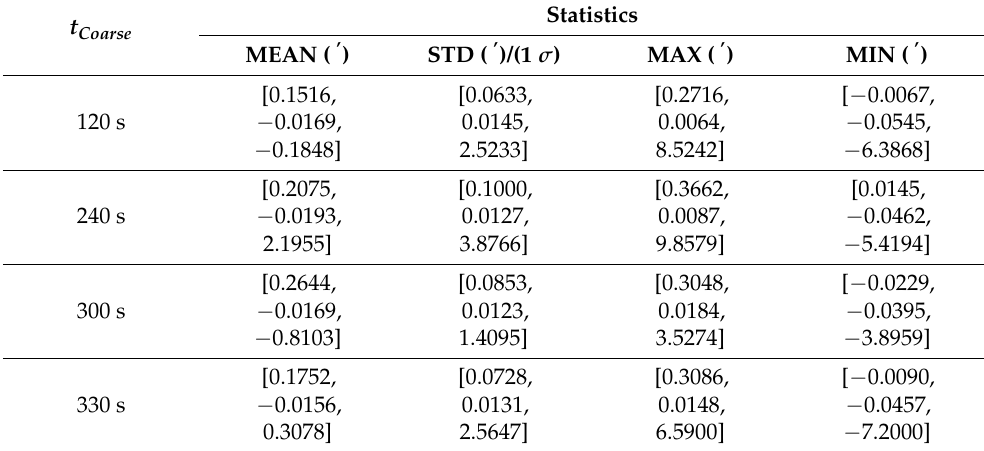
Table 6. Statistics for simulation results.